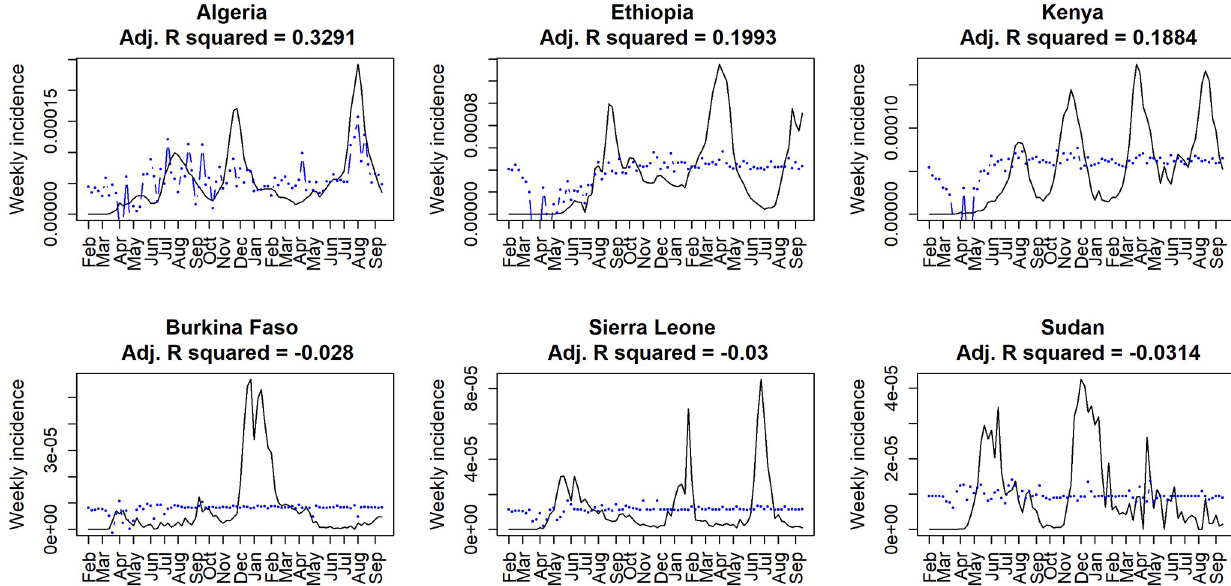
Fig 4. Best and worst performing countries from the basic regression analysis of Google Health Trends (GHT) data. When analyzing whether GHT correlated with case incidence (black line) via a multiple linear regression analysis (blue line), the three best performing countries were Algeria (DZA), Ethiopia (ETH), and Kenya (KEN), respectively (upper panels). The three worst performing countries were Burkina Faso (BFA), Sierra Leone (SLE), and Sudan (SDN), respectively (bottom panels).